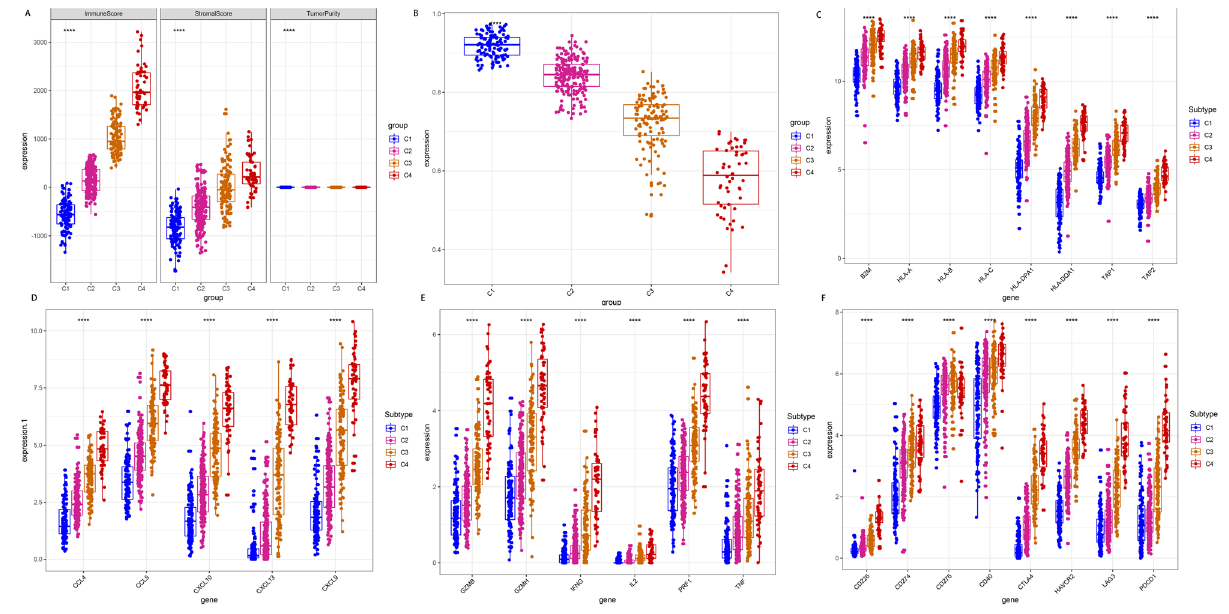
Figure 4. A box plot of immune scores and expression levels of immune-related molecules in the different subtypes. ( A , B ) The immune scores and immune matrix scores in the four clusters. Clusters 3 and 4 had higher immune scores than Clusters 1 and 2. ( C – F ) The expression levels of multiple immune molecules were compared in the four clusters. The expression levels of the molecules were higher in Clusters 3 and 4. *, p < 0.05.